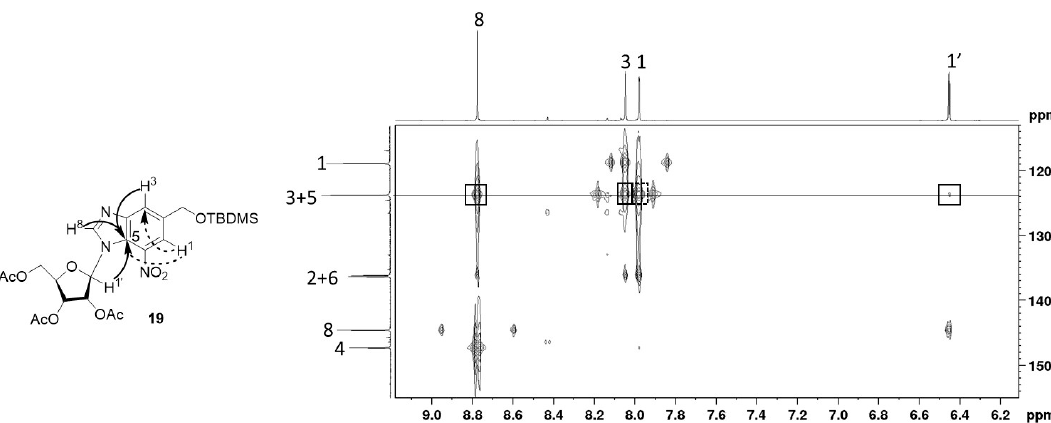
Figure 2. Decisive correlations with C5 on the N7-linked base in compound 19 are indicated by bold arrows in the structure on the left and boxed in the HMBC spectrum. Correlations indicated with a dashed arrow are overlapping (box in dashed lines). Labels correspond to assignments in proton and carbon dimensions.